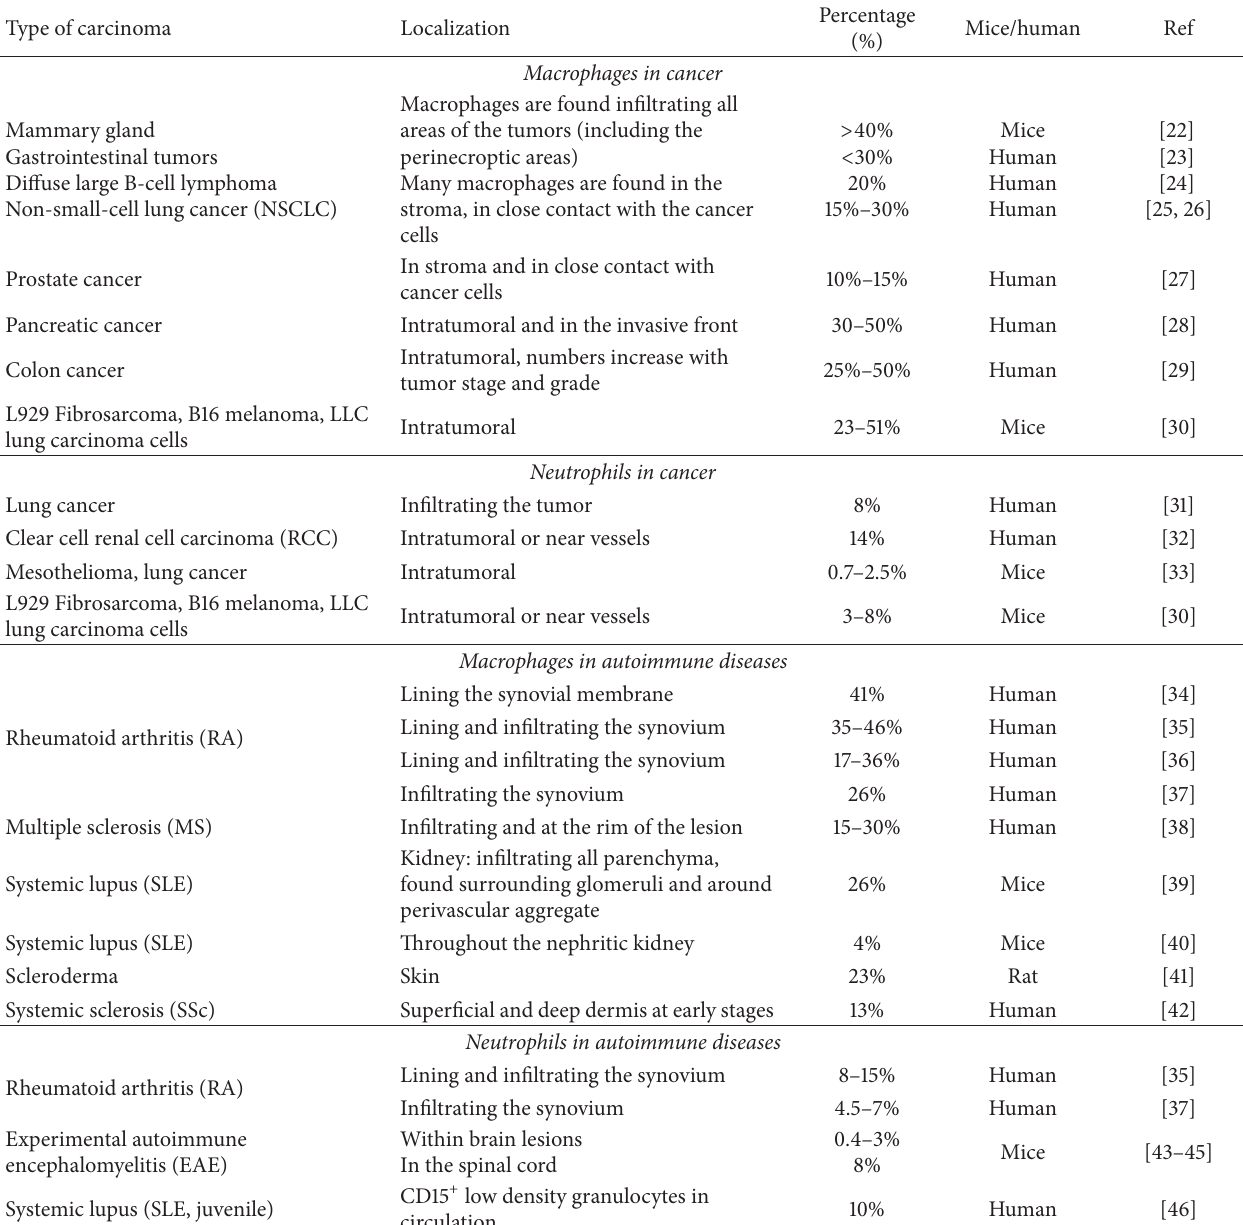
Table 2: Examples for the distribution of macrophages and neutrophils in different types of cancer and autoimmune